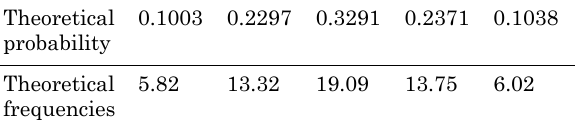
table 12. theoretical probability and theoretical frequencies of the expert assessment of the importance of the lease indicators